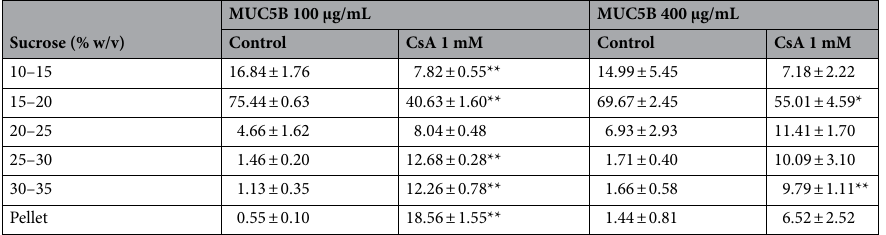
Table 2. Percentage of MUC5B in sucrose gradient fractions (MUC5B concentration dependence). Results are presented as the mean ± s.e.m. (n = 3) from 3 independent experiments. * P < 0.05, ** P < 0.01 compared with control condition (ANOVA followed by Dunnett’s method). The percentage of MUC5B in fractions across the sucrose gradient was calculated from Fig. 3.